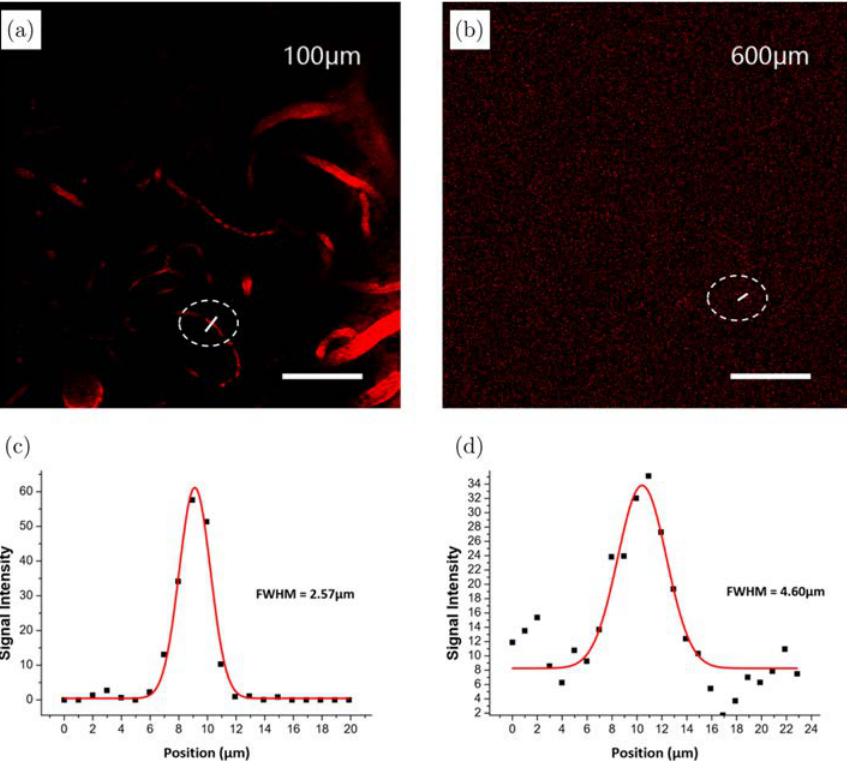
Fig. 10. 3PF signals in cereberal vasculature of rats at di®erent vertical depths. (a) and (b) 3PFM images of the vasculature at 100 (cid:1) m (a) and 600 (cid:1) m (b) to analyze FWHMs. (c) and (d) FWHMs of 3PF signal of images at 100 (cid:1) m (c) and 600 (cid:1) m (d). Scale bar: 100 (cid:1)